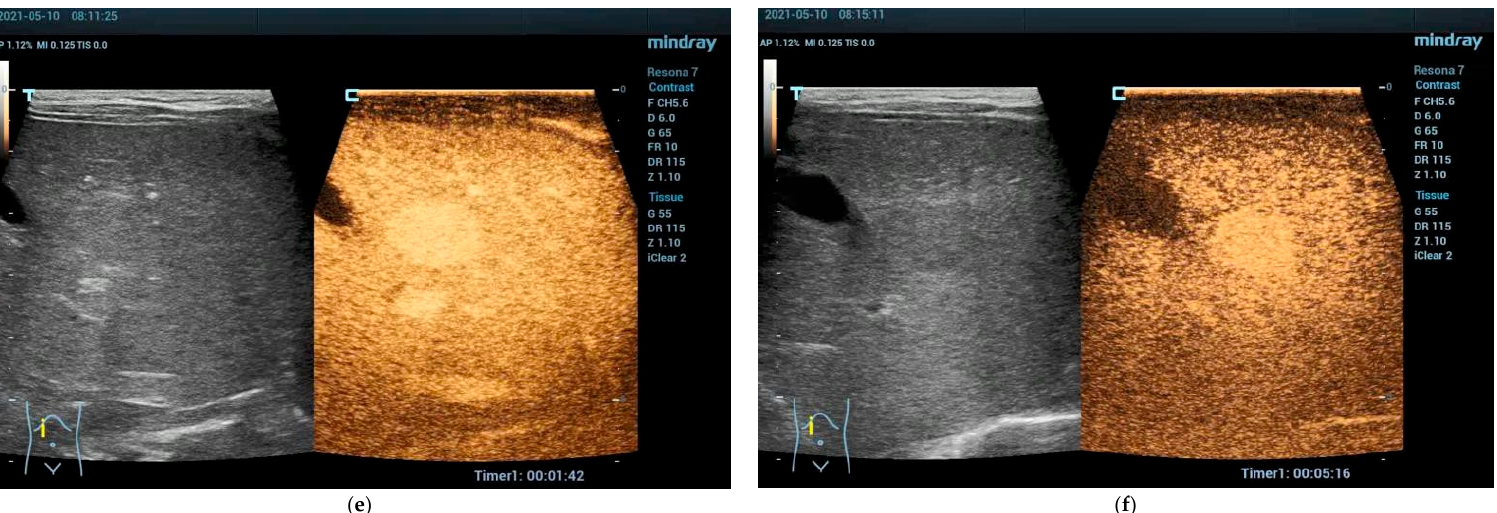
Figure 1. Congenital hemangioma, 6-day-old girl. Incidentally detected FLL. No cutaneous hemangiomas or other malformations visible, no symptoms. B-mode with 19 mm × 11 mm hypoechoic FLL in segment 4 ( a ). Color Doppler shows centrally located arterial vessel within the FLL ( b ). Contrast-enhanced ultrasound in the early arterial phase reveals peripheral nodular contrast enhancement ( c ) with almost complete centripetal fill ( d ). In the portal venous phase homogeneously hyperenhancement ( e ). No washout in the later phases ( f ) (L11-3U transducer).